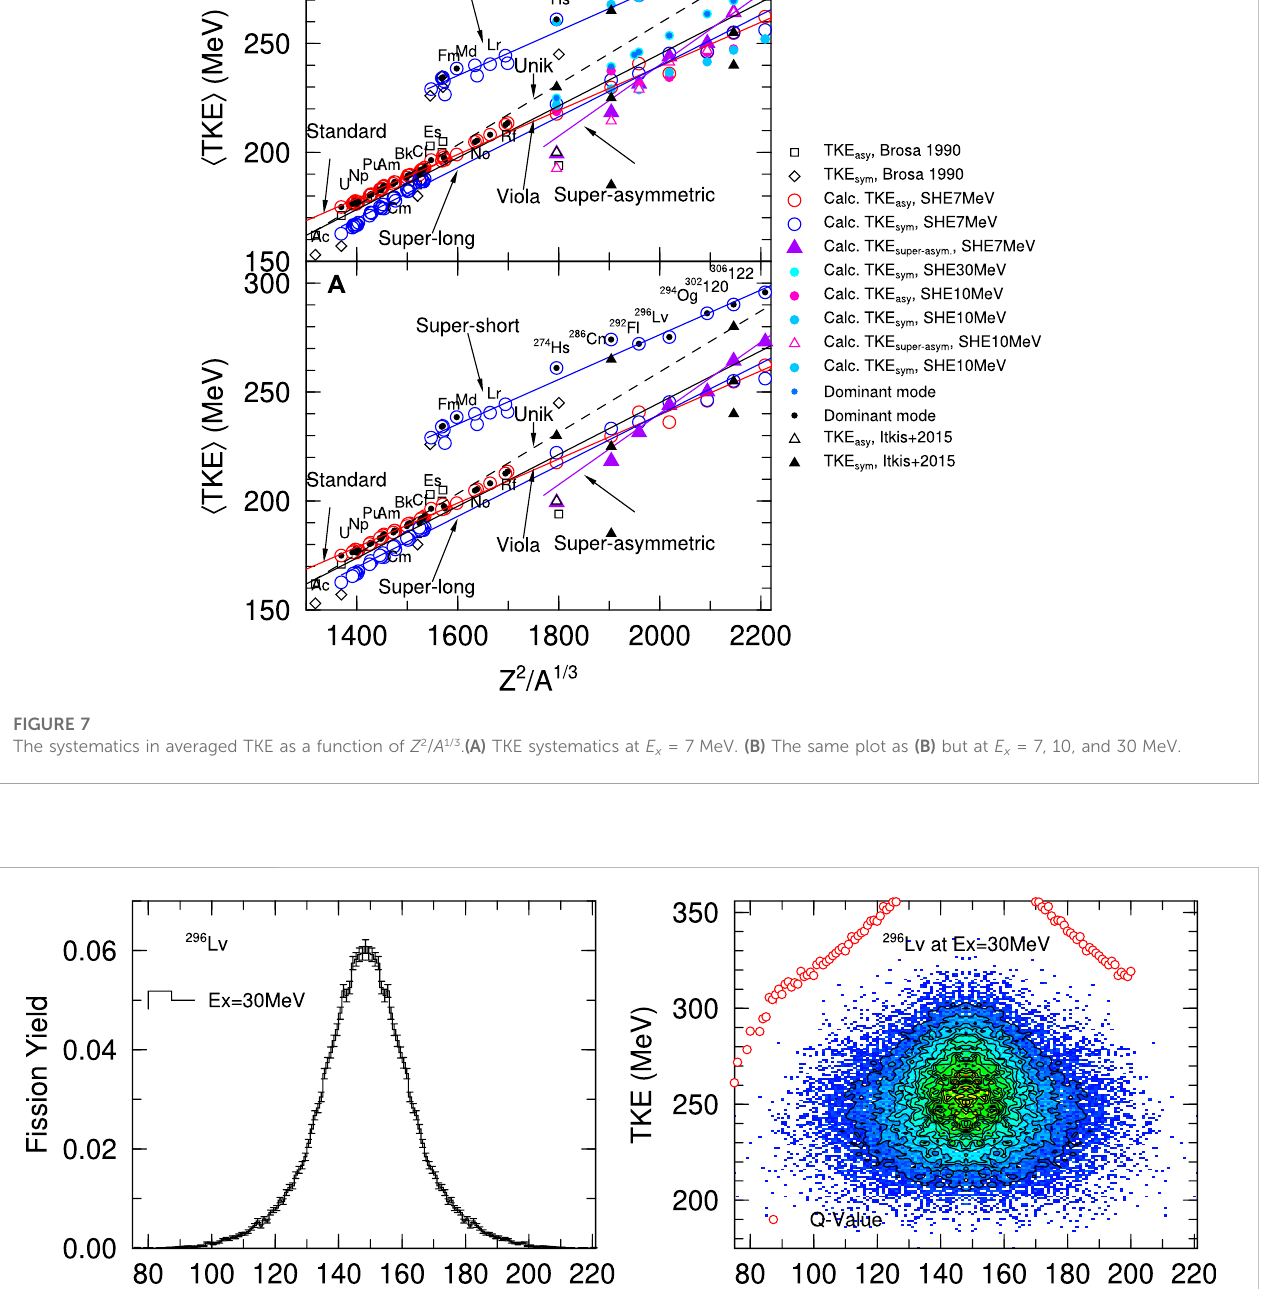
based on the assumption that the ratio of proton to neutron density is unchanged (UCD). In SHEs, the double shell closure of 208 Pb governs nuclear fi ssions instead of 132 Sn in actinides, as discussed in Figure 5.